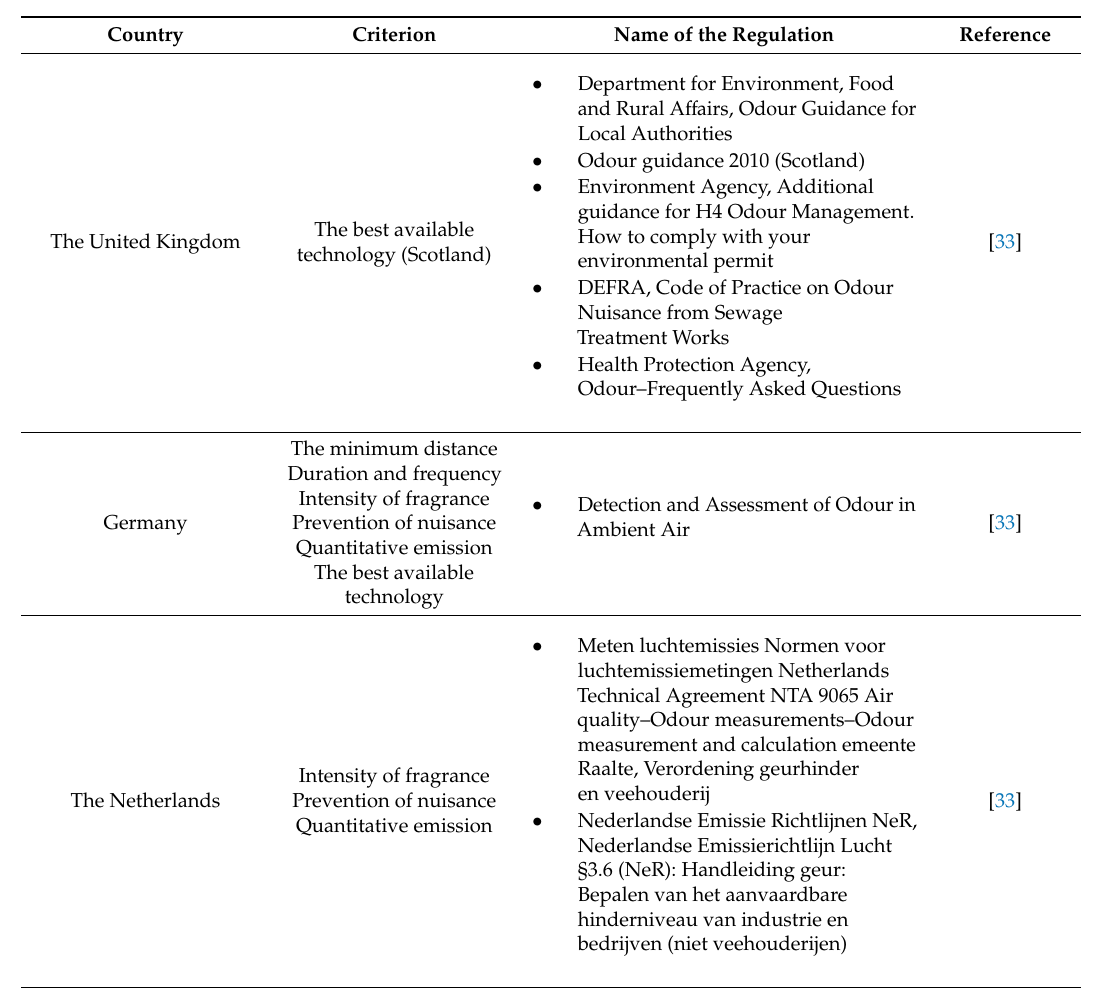
Table 3. Management to prevent or curb odour annoyance in selected